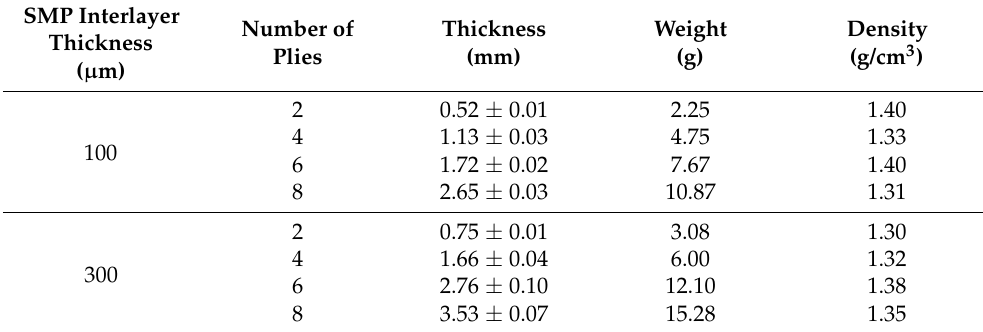
Figure 1. Samples for the durability tests. Table 1. Physical properties of the SMPC laminates. Table 1. Physical properties of the SMPC laminates.